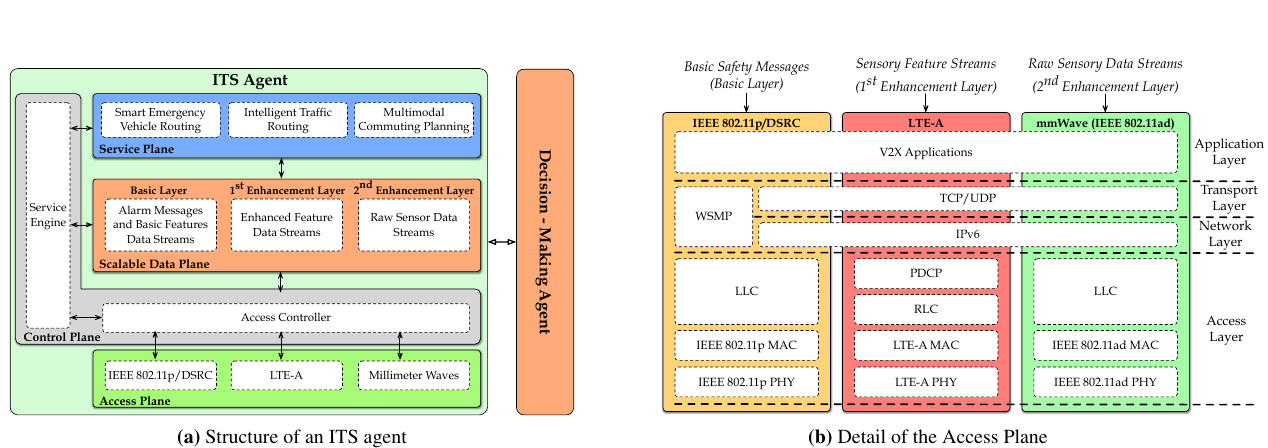
Figure 3. Proposed ITS agent architecture and detail of the proposed Access Plane incorporating the considered RATs. Table 2. Relevant messages for next-generation ITS